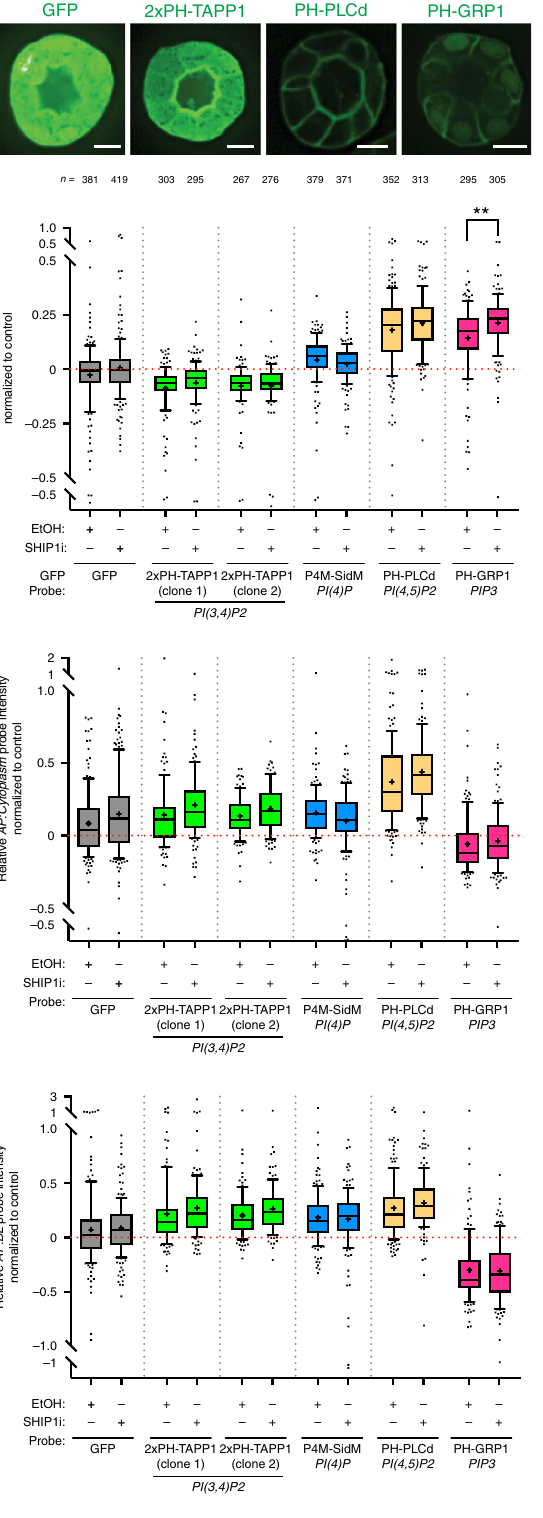
utilized. For validation of endogenous PI(3,4)P 2 staining in 3D, we optimized staining protocols. We tested four staining protocols in addition to the commer- cially recommended protocol (PI(3,4)P 2 Ab, Echelon, Z-P034), (i) 43 , (ii) 12 , (iii) 24 , (iv) 44 . Buffer four produced endogenous labeling patterns mirroring EGFP-2xPH- TAPP1 and was used for all further PI(3,4)P 2 staining. Brie fl y, staining in buffer four is as follows: cysts were fi xed in 4% PFA followed by three washes in